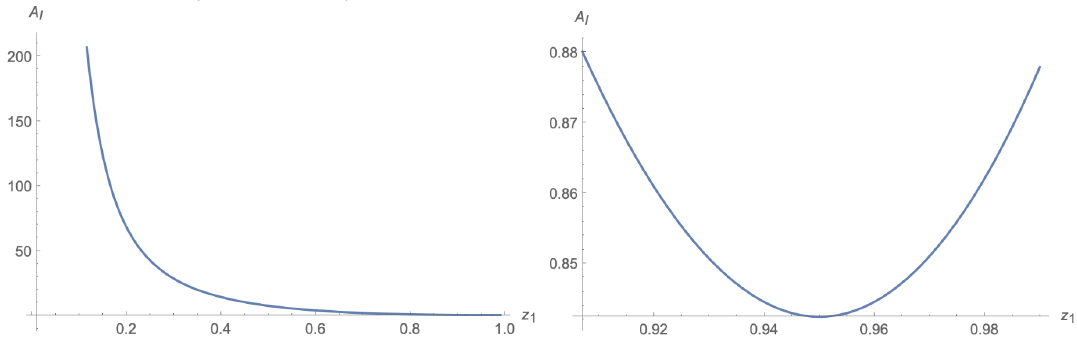
Figure 10 . Relation between the area A I and the endpoint z 1 on the left brane, which shows that area functional (3.4) becomes minimal at z 1 ≈ 0 . 950